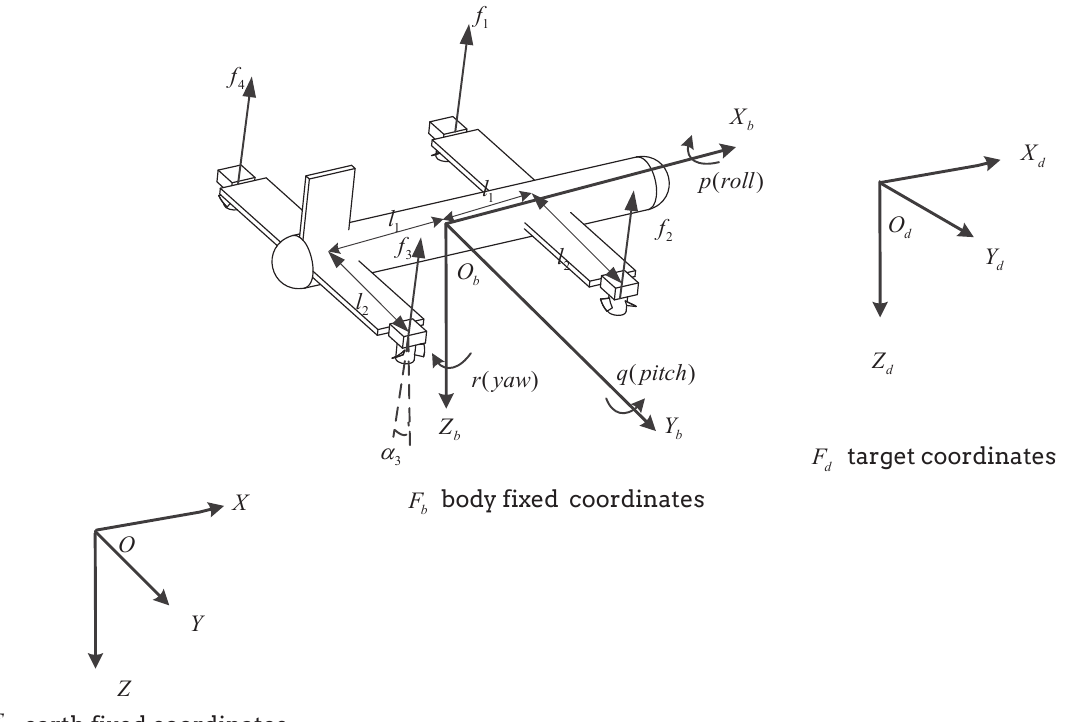
Figure 1. Mechanical configuration and co-ordinates of the negative-buoyancy quad-tilt-rotor autonomous underwater vehicle